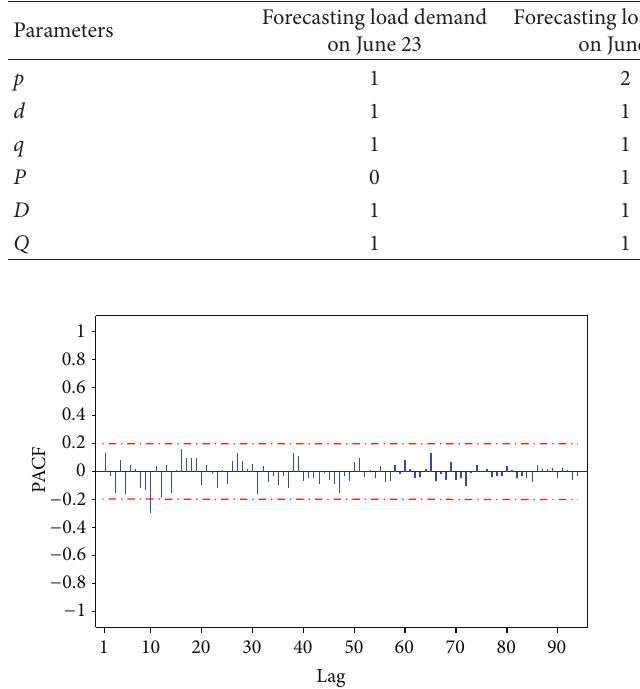
Figure 3: PACF figure in forecasting the load demand on June 23 by seasonal ARIMA model.